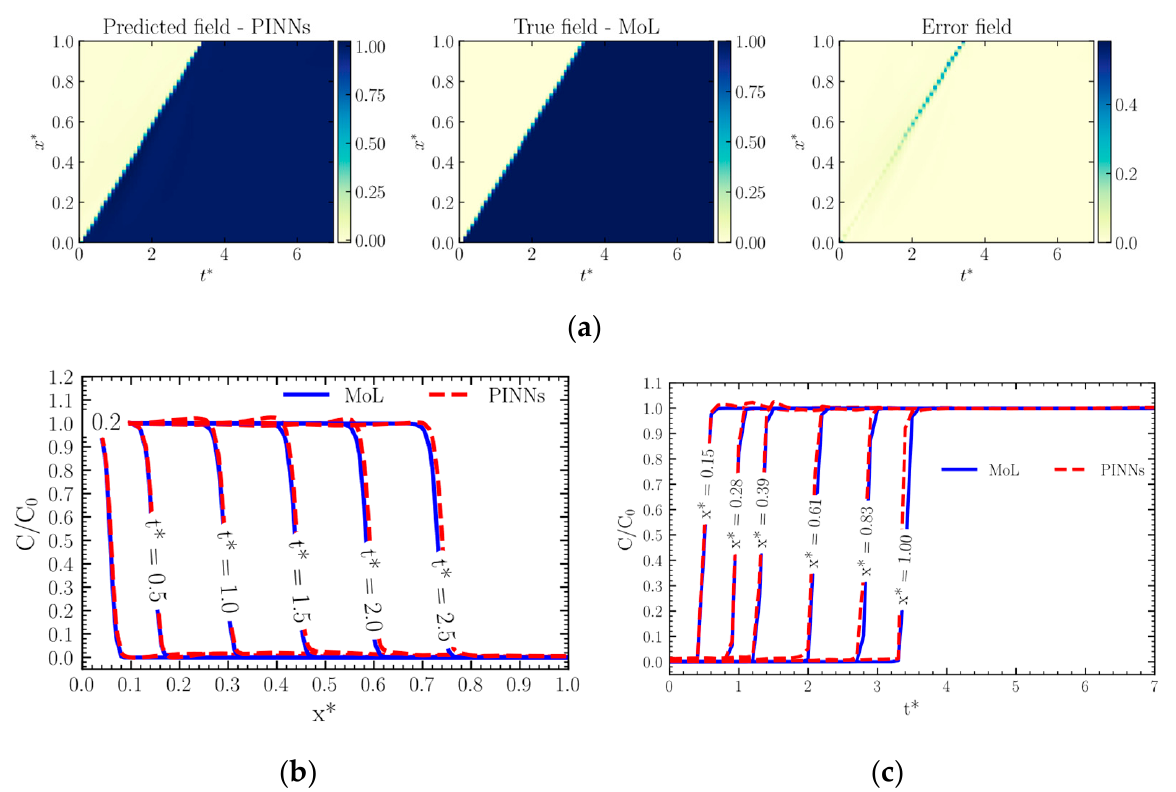
Figure 4. MoL and PINNs solution’s comparison for adsorption experiment.